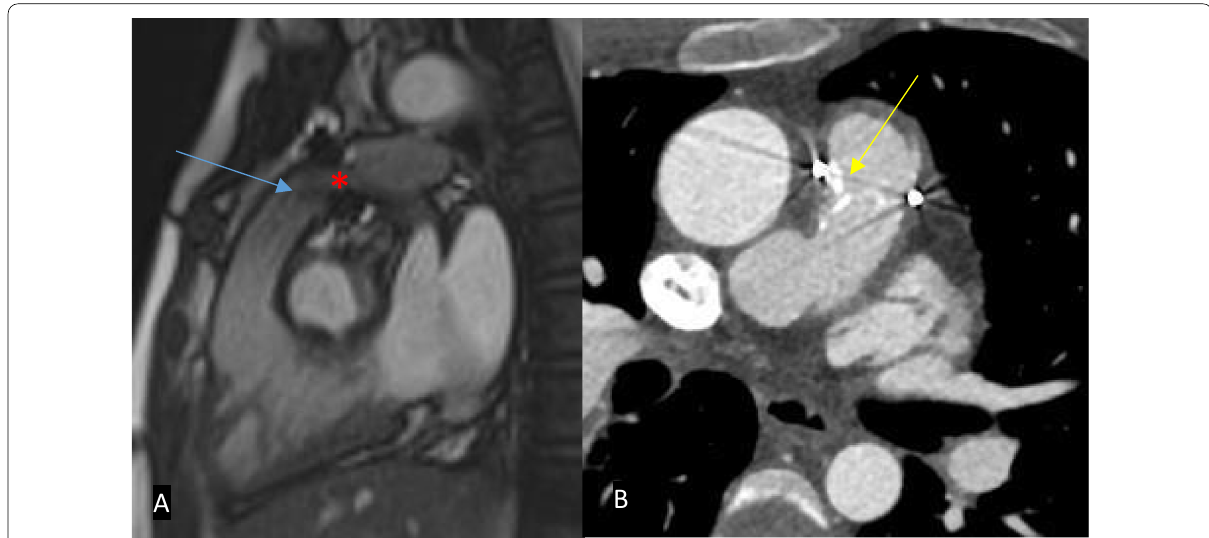
Fig. 17 MRI SSFP cine ( A ) and contrast-enhanced CT ( B ) images in a patient with a valved (red asterisk) RV-PA conduit. A Single shot of the RVOT demonstrating pulmonary regurgitation (blue arrow). B Single axial image demonstrating calcification around the valve (yellow arrow). RV: right ventricle; PA: pulmonary artery; RVOT: right ventricular outflow tract